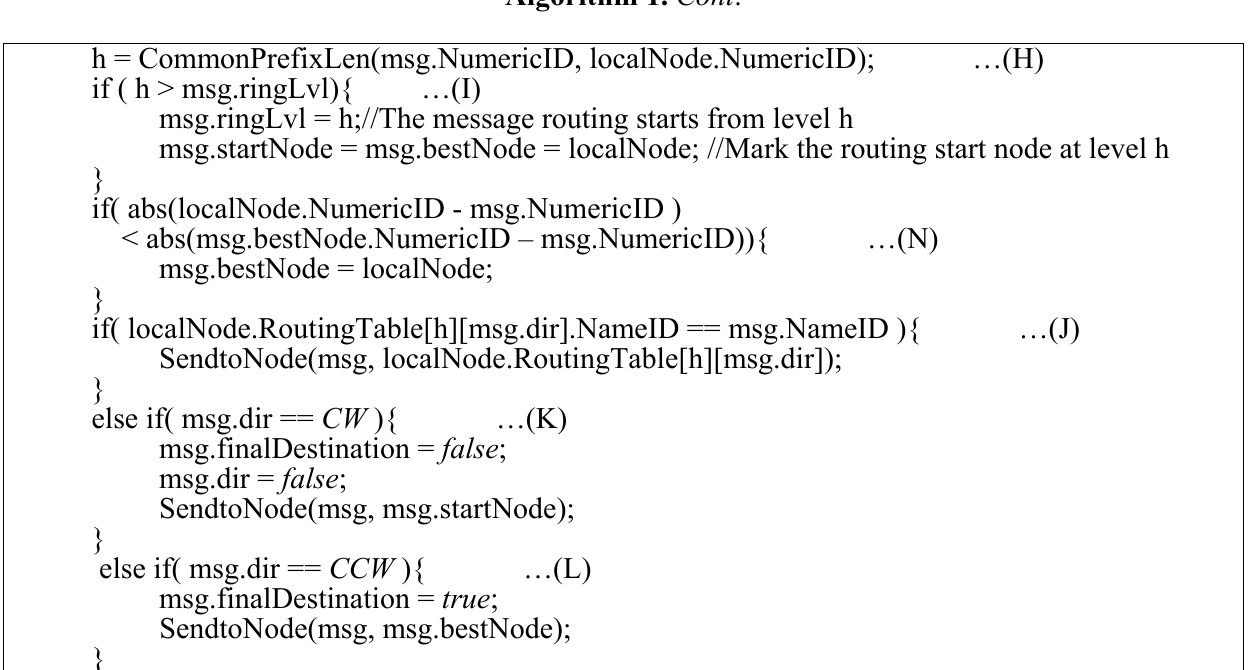
Algorithm 1. Cont